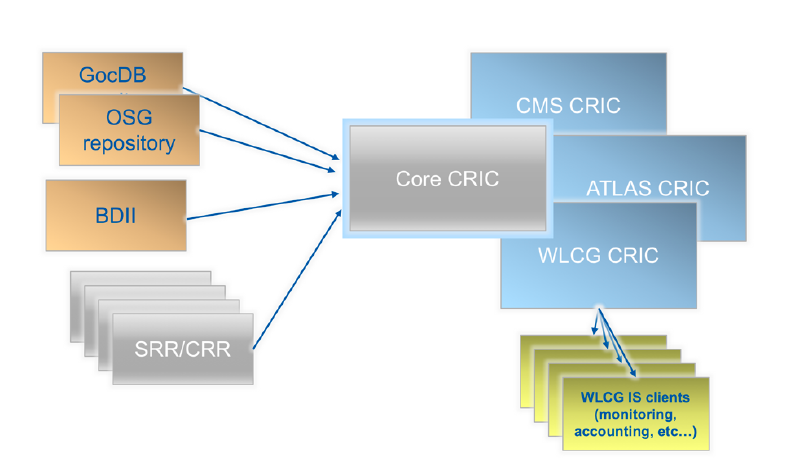
Fig. 1. CRIC data